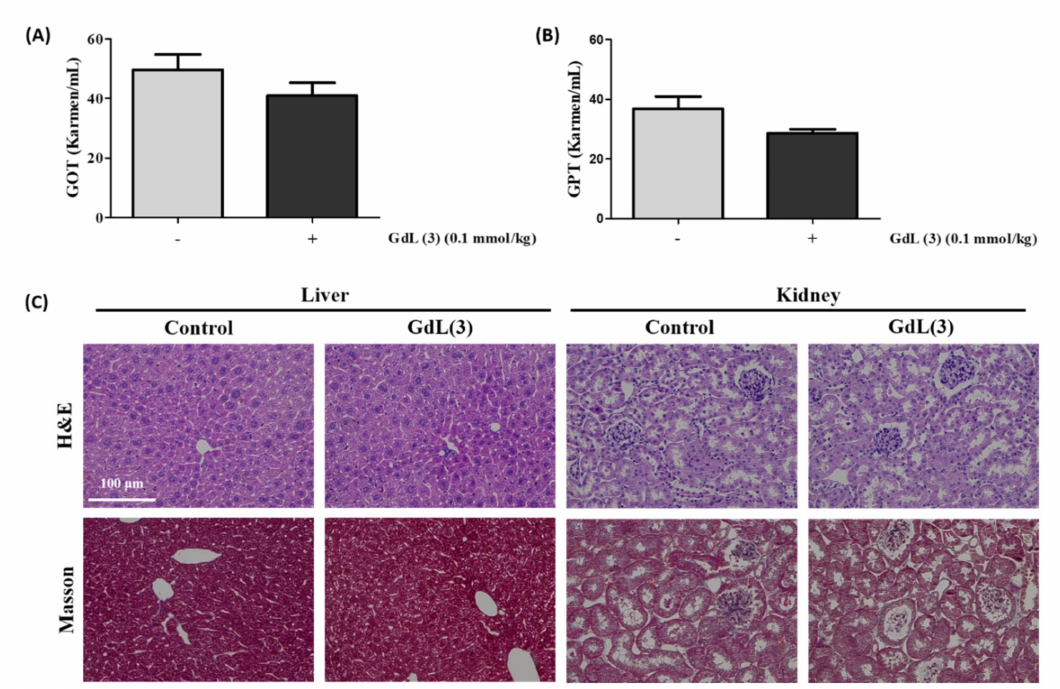
Figure 9. Toxicity data of GdL (3). ( A ) Glutamic oxaloacetic transaminase (GOT) and ( B ) glutamic pyruvic transaminase (GPT) data of GdL (3). ( C ) Micrographs of hematoxylin and eosin (H&E)- and Masson-stained liver and kidney tissue slices before and after 24 h of GdL (3) treatment (n = 3 per each group). Scale bar = 100 µ